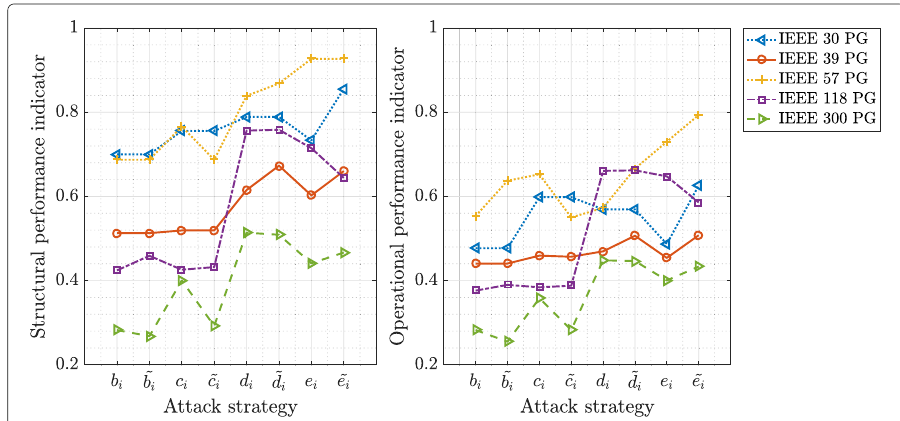
Fig. 6 The structural performance indicator ¯ σ (left) and the operational performance indicator ¯ γ (right) in IEEE power grids after the targeted attacks